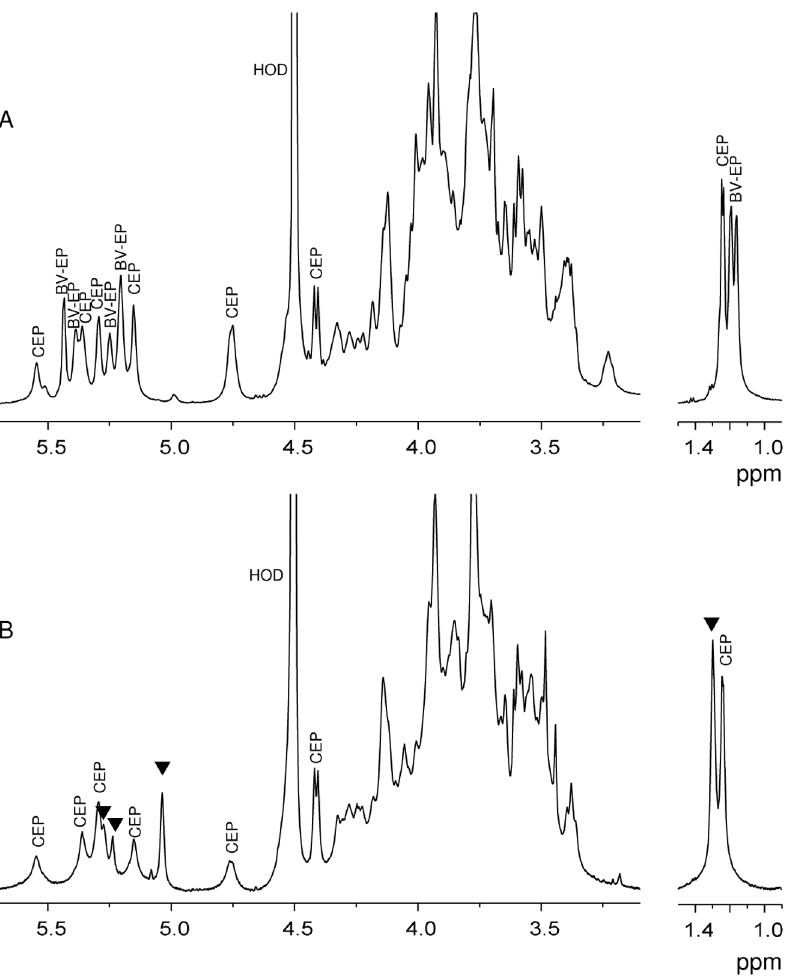
Figure 3. 1 H-NMR spectra of the exopolysaccharides produced by B.vietnamiensis and B.multivorans . A) 1 H-NMR spectrum of the EPOLs mixture produced by B. vietnamiensis on YEM agar plates. Anomeric proton signals and methyl groups of 6-deoxy sugars belonging to CEP and BV- EP are shown. B) 1 H-NMR spectrum of the EPOLs mixture produced by B. multivorans C1576 on YEM agar plates: anomeric proton signals and methyl groups of 6-deoxy sugar of CEP are indicated, while triangles indicate new signals.